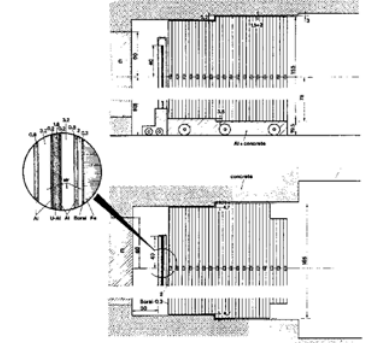
Figure 1 . The true model of ISPRA-Fe Experiment.